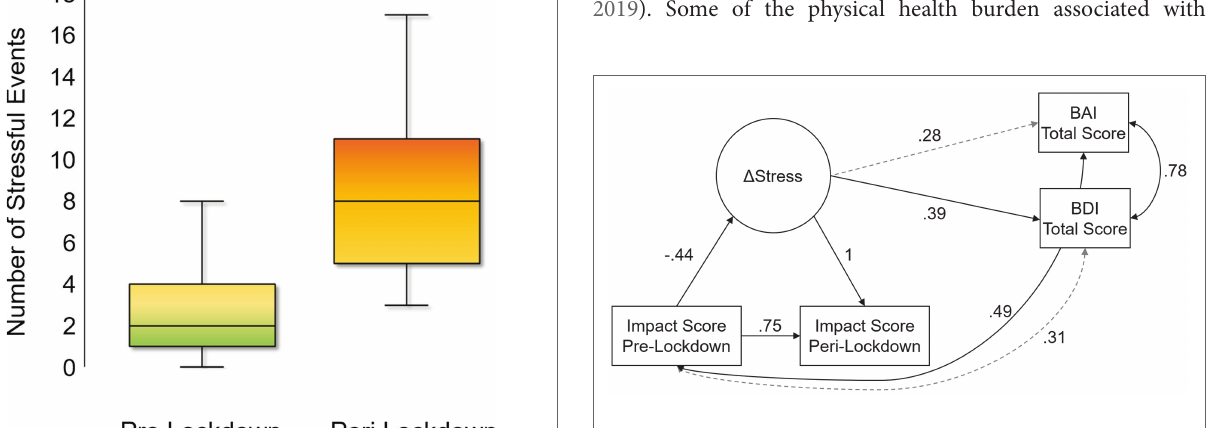
FIGURE 3 | Latent Change Score Model of Stress, Anxiety, and Depression. The latent change score model of changes in stress impact ( Δ Stress) predicting self-reported anxiety Beck Anxiety Inventory (BAI) and depression Beck Depression Inventory (BDI) scores. Double-headed arrows represent correlations, and single-headed arrows represent unidirectional effects; solid black lines indicate statistically significant effects at the p < 0.05 level, and dashed gray lines indicate non-statistically significant effects. Coefficients reported in the figure are standardized effects.